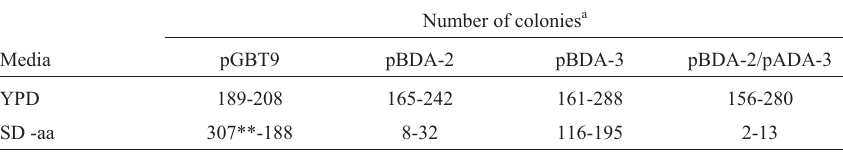
Table 2 - Plasmid cure in Y190 cells.